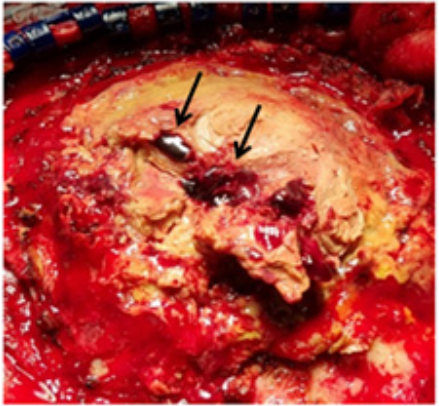
Figure 5. Intraoperative view shows a thick yellowish mass and microbleeds (arrows) occupying the epidural space. Subsequently, aggressive debridement and copious irrigation with autologous bone flap removal were performed. During the surgery, a white-yellow tissue layer was observed on the surface of the dissolved cranioplasty material. After removal of the resorbed autologous bone, an organized, bright brown and rigid abscess mixed with a hemorrhagic component was observed (Figure 5). The epidural space was sufficiently washed out using vancomycin mixed with saline irrigation. After surgery, a full course of systemic antibiotics was administered according to the recommendations of an infectious disease consultant, and the patient was transferred to the internal medicine department for further antibiotic treatment. The postoperative course was une- ventful. On postoperative day 2, he was alert and started to speak with normal articulation, and his speech was completely normal on day 7. The differential diagnosis for transient aphasia is ischemic and hemorrhagic strokes, neoplasms, cerebral abscesses, and traumatic brain contusions [3]. In our case, the purulent discharge culture was negative before surgery, as well as during the removal of autologous bone graft with surrounding reactive tissues; however, we eventually diagnosed the case as a delayed infection after cranioplasty. Our patient also had a normal body temperature, nor- mal WBC count, and normal levels of infection markers, such as ESR and CRP. The most reliable indicators of delayed infection after cranioplasty are the clinical features of the patients and imaging studies as well as laboratory results. We report a rare case of delayed cranioplasty infection that presented as aphasia 6 years after the cranioplasty. This report suggests that the possibility of such delayed infection should be considered. Furthermore, surgical debridement and bone flap removal for delayed infection should be conducted as soon as possible even when a patient presents with subtle infectious signs. Author Contributions: Conceptualization, S.W.K.; methodology, J.H.K. and S.W.K.; validation, S.W.K.; formal analysis, S.W.K.; investigation, J.H.K.; writing—original draft preparation, J.H.K. and S.W.K.; writing—review and editing, D.K.K. and S.W.K. All authors have read and agreed to the published version of the manuscript. Funding: This study was supported by a research fund from Chosun University hospital, 2022. Institutional Review Board Statement: Not applicable. Informed Consent Statement: Consent for publication was obtained from the patient. Conflicts of Interest: The authors have no financial conflict of interest. References 1.